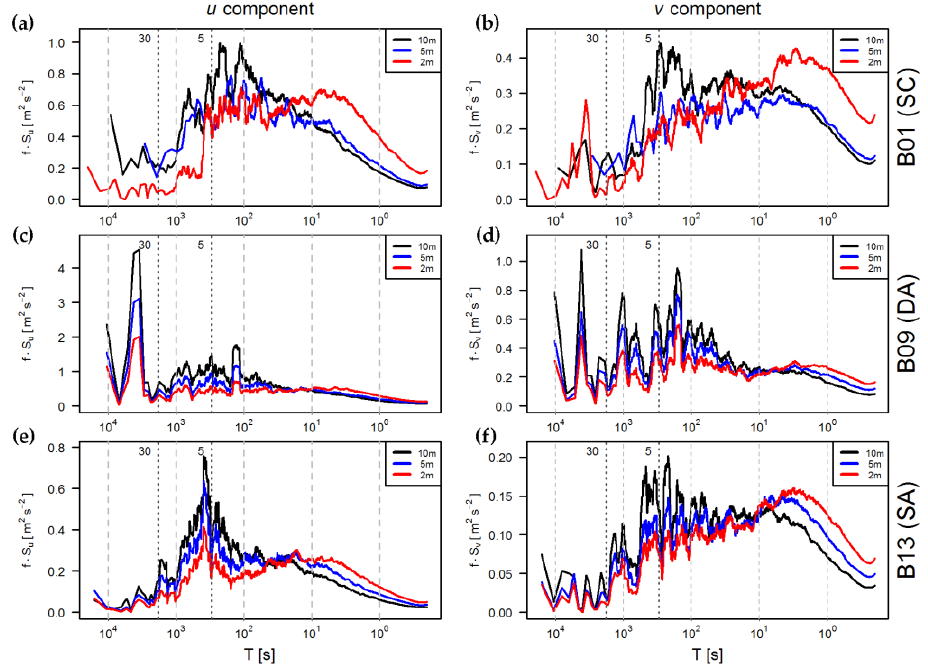
Figure 12. A log-linear representation of the frequency-weighted power spectral densities of the longitudinal ( u ) component ( a , c , e ) and lateral ( v ) component ( b , d , f ) of the wind speed at levels 2, 5, and 10 m, for the three selected bora episodes; ( a , b ) B01 (SC); ( c , d ) B09 (DA); ( e , f ) B13 (SA). Thick dashed black vertical lines indicate the 30-min and 5-min periods.